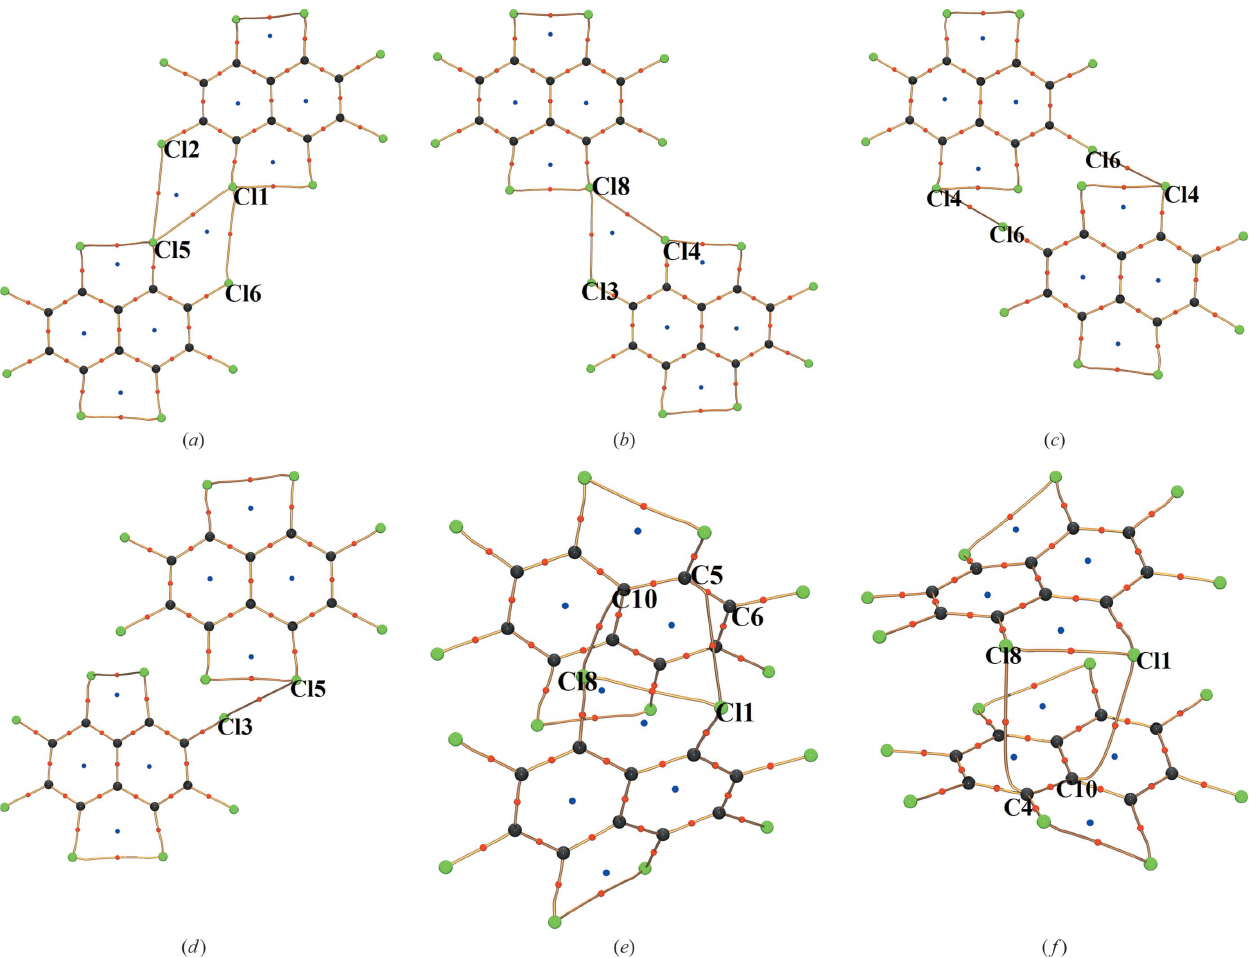
Figure 12 Molecular graphs showing intramolecular and various intermolecular bond paths of different dimers in the crystal 46 Sarkar and Row (cid:3) Peri versus intermolecular interactions in naphthalene